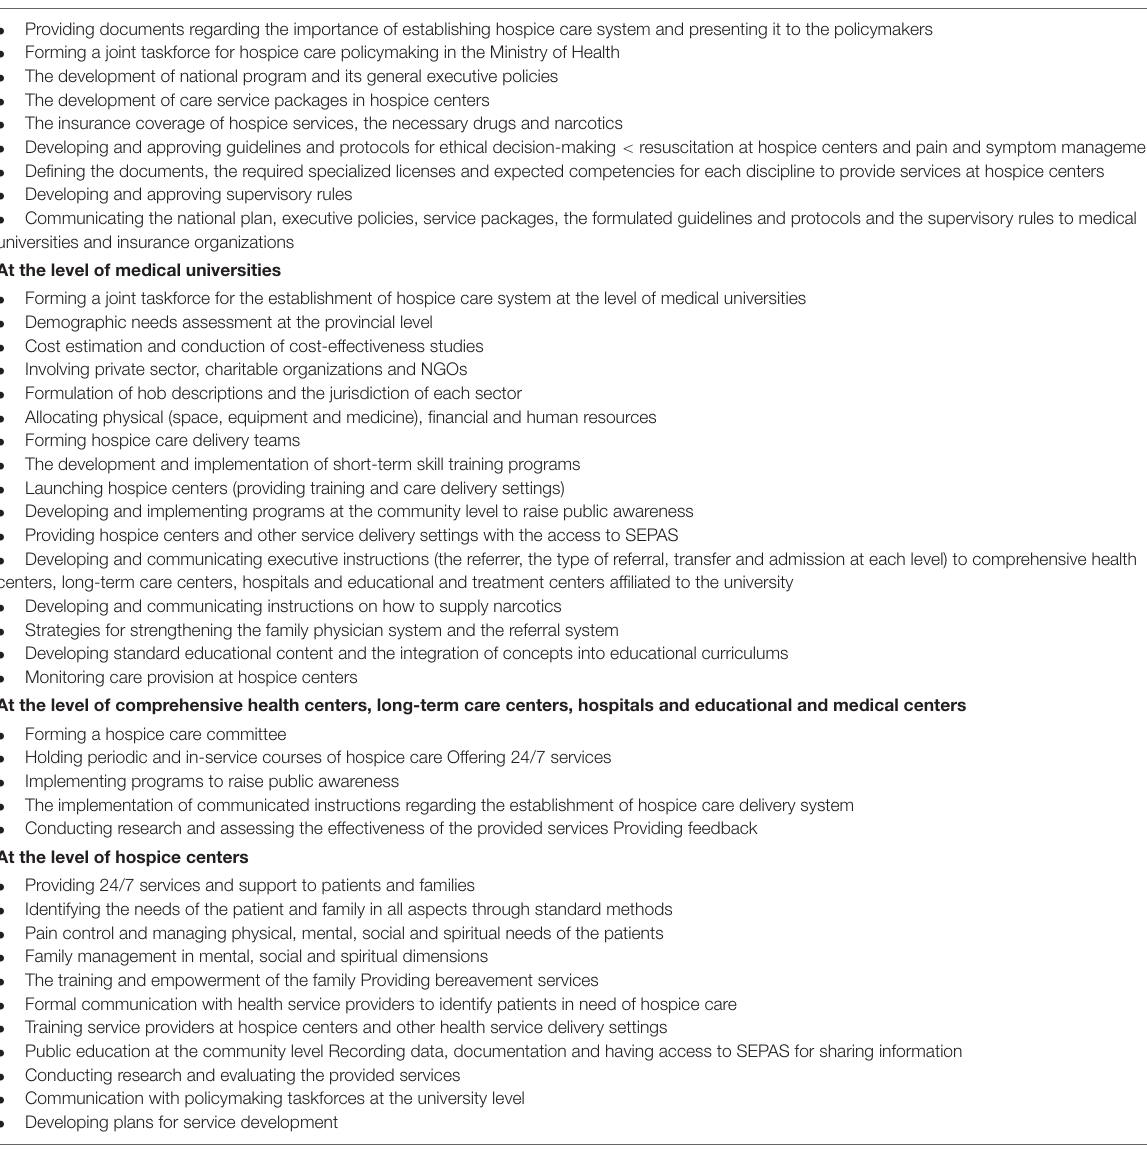
TABLE 5 | The operational stages of establishing hospice care delivery system for adult patients with cancer. At the level of the Ministry of Health and Medical